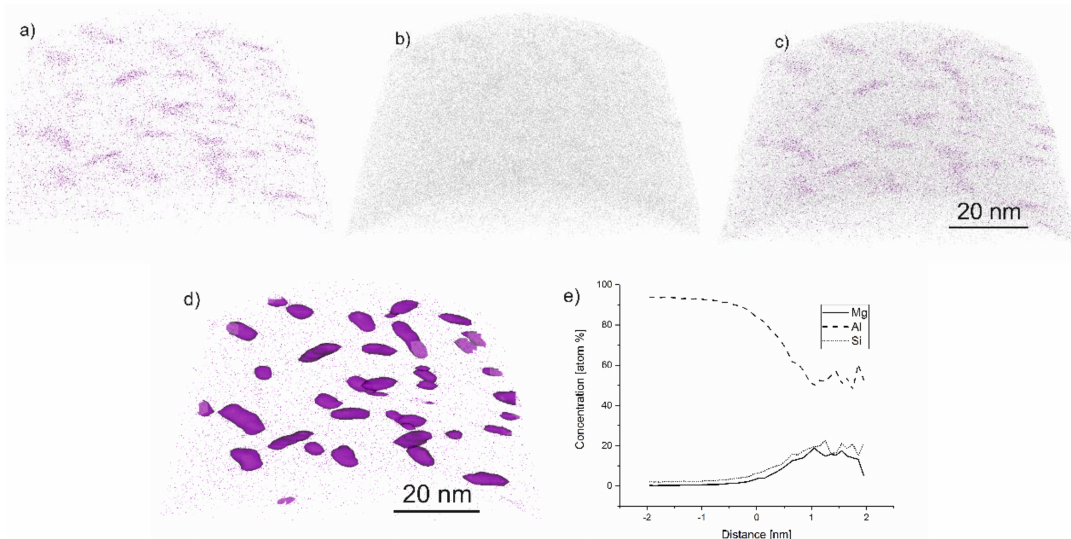
Figure 8. Atom distribution on LPBF-AlSi10 in the as-built condition for Mg ( a ) and Si ( b ) and both elements together ( c ). ( d ) shows the distribution of the Mg atoms with 3 at.% isosurface; ( e ) is the proxigram, showing the chemical composition for all the precipitated phases; the distance ( x -axis) refers to the distance relative to the interface / isosurface. Zero indicates the interface itself, negative x -values the chemical composition outside (matrix) and positive x -values inside (cluster) the